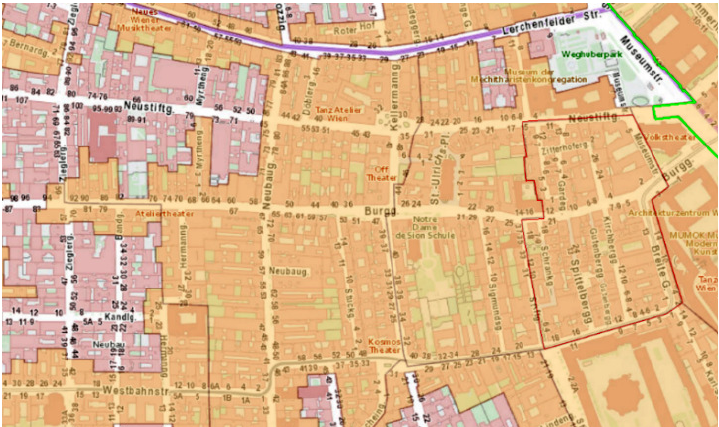
Figure 7. Schutzzone Spittelberg (red marking) and various other protected areas: Plan from 2022. Source: City of Vienna (n.d.‐a).